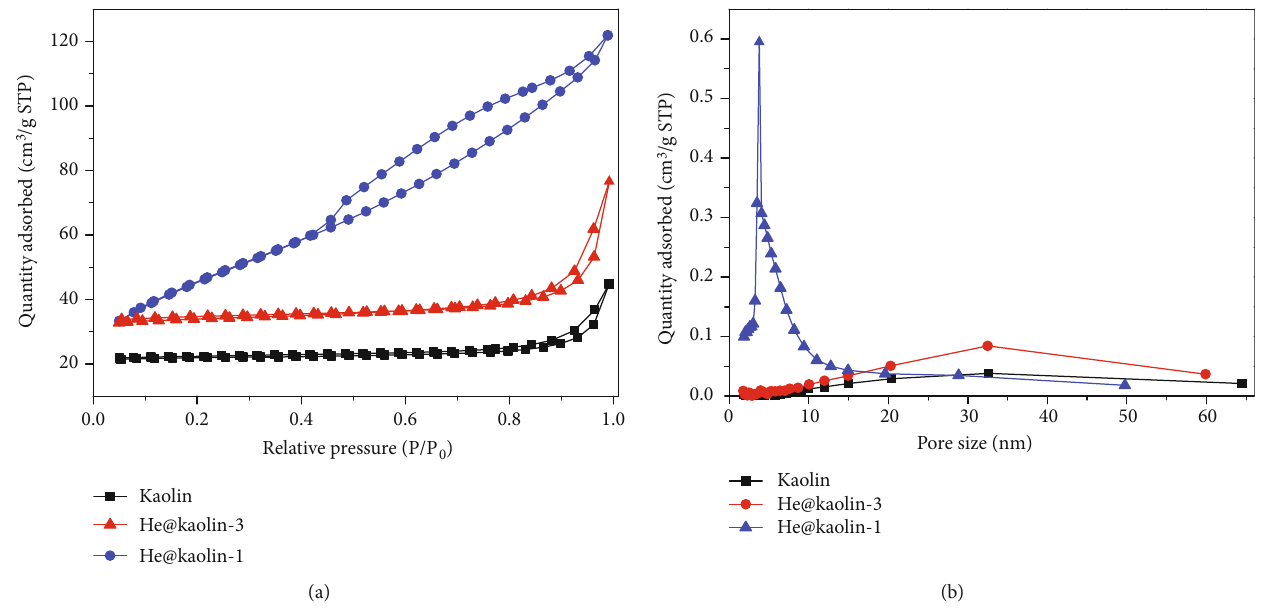
Figure 4: N adsorption-desorption isotherm and pore size distribution of kaolin, He@kaolin-3 and He@kaolin-1. 2